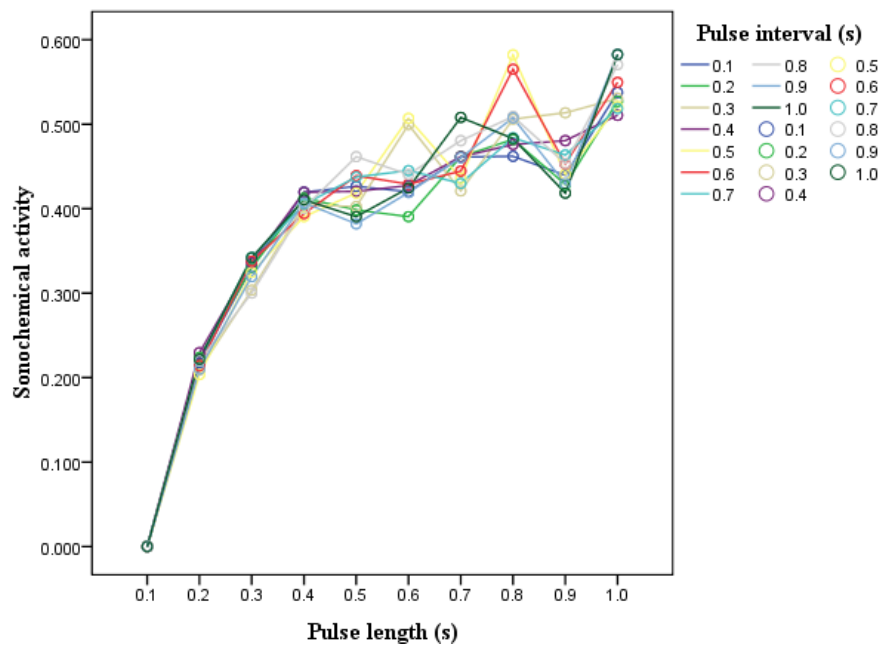
Figure 4. Interaction between pulse length (0.1–1 s) and pulse interval (0.1–1